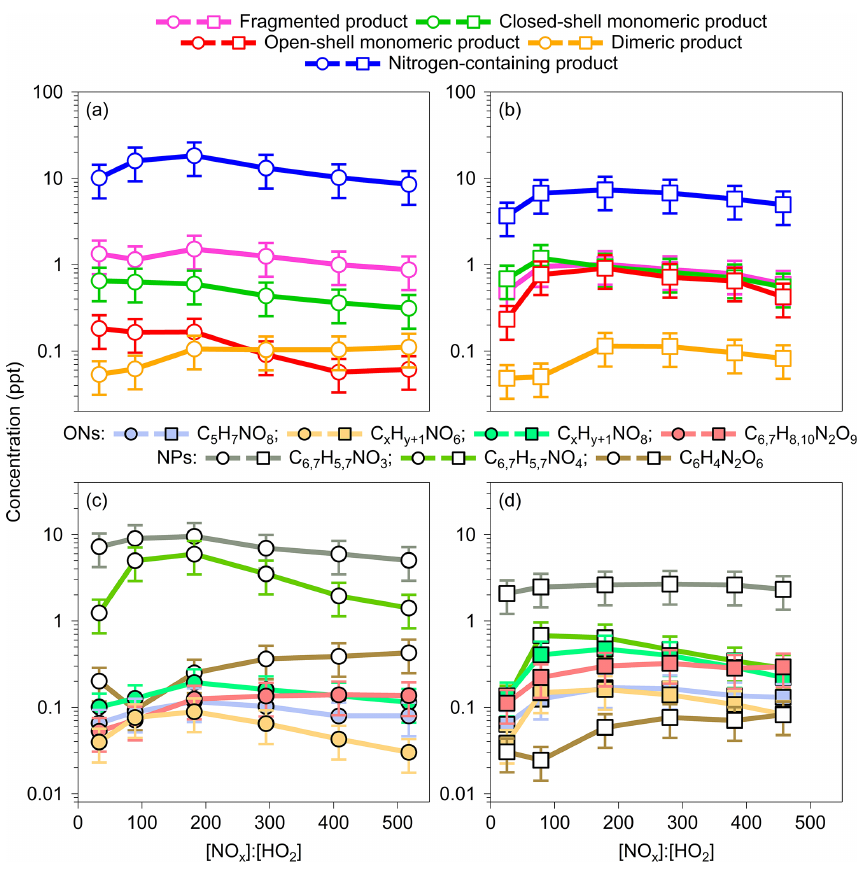
Figure 4. Concentrations of fragmented, monomeric closed-shell, open-shell, dimeric, and nitrogen-containing products formed by benzene and toluene oxidation under high-NO x conditions (OFR254-5–iN 2 O1.1/4.4) at various [NO x ]:[HO 2 ] levels. Data for OFR254-5–iN 2 O1.1 experiments were averaged and are shown as the first data point in each panel. For the benzene oxidation, both x and y are 6. For the toluene oxidation, x is 7, and y is